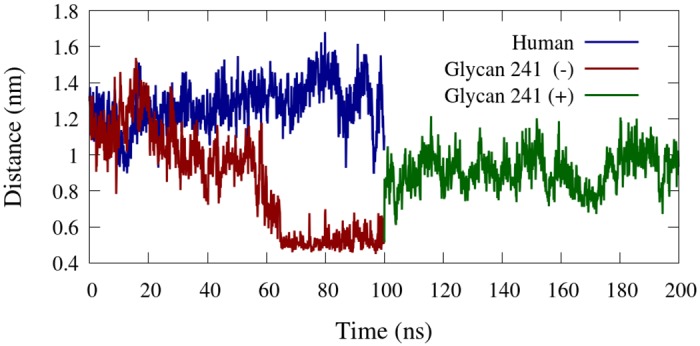
Active site residue distance.Center of mass distance between ASP70 and combined residues THR284 and PRO285. These residues are located at the top of the active site gorge, and characterize the opening and closing of the gorge.